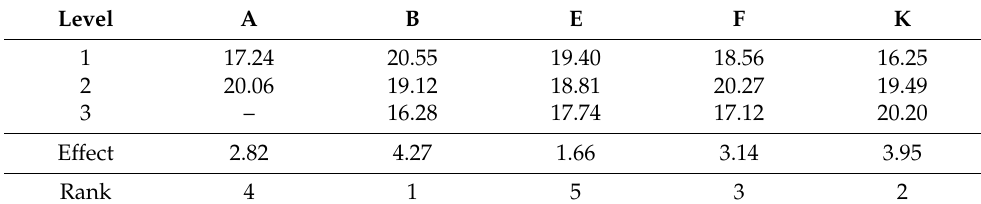
Table 12. Factor response table for the average luminance of the L 18 (2 1 × 3 7 ) experiment.